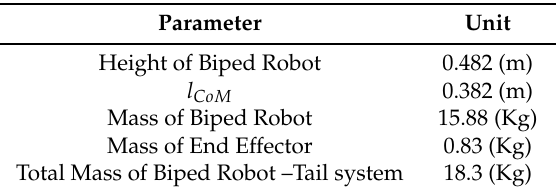
Table 3. Biped robot